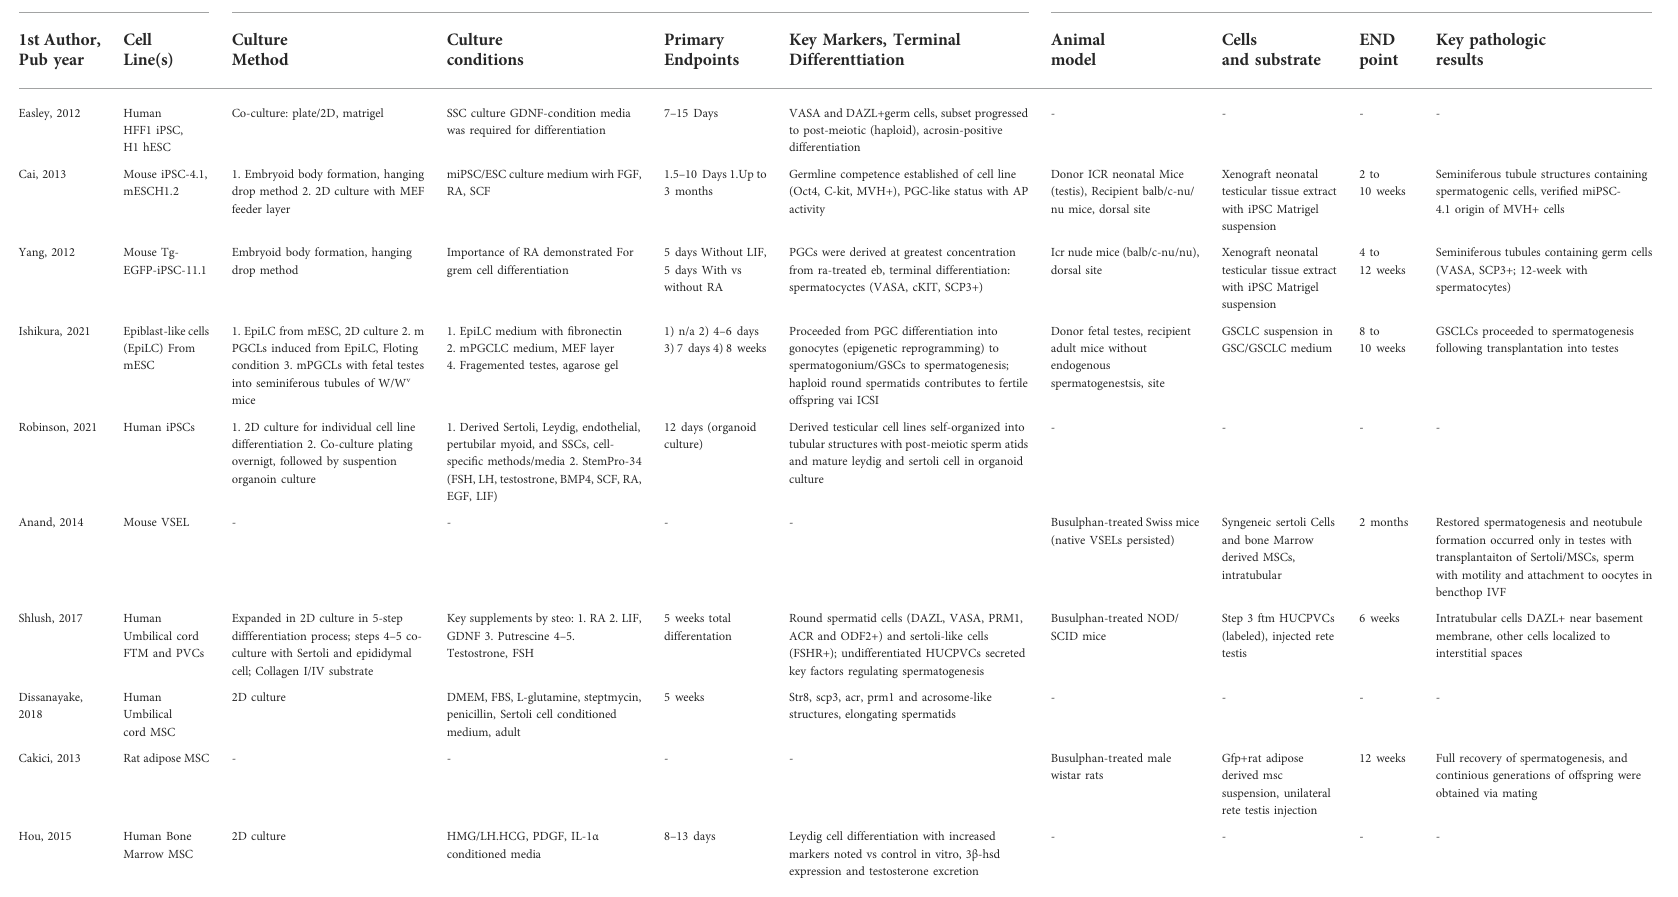
TABLE 1 Studies generating testicular parenchymal cells de novo using